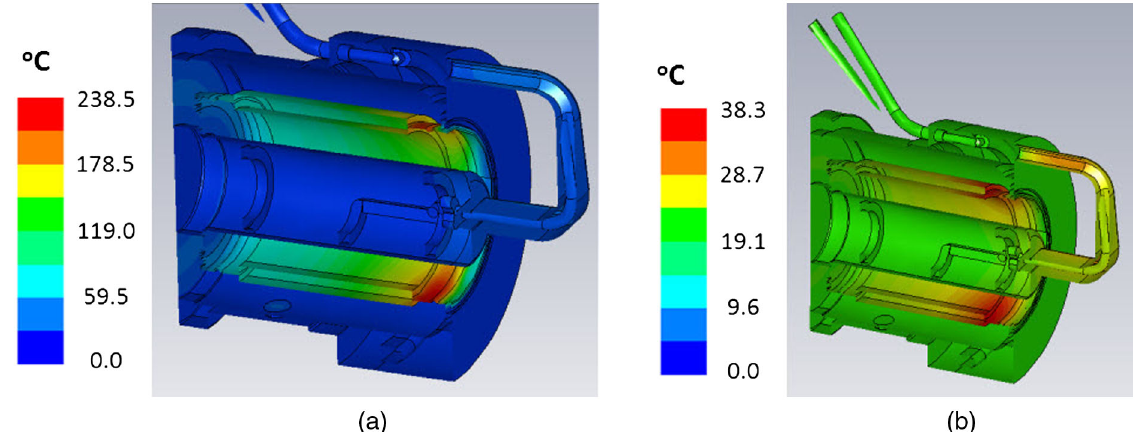
FIG. 19. Results of thermal simulations from CST with steel or copper